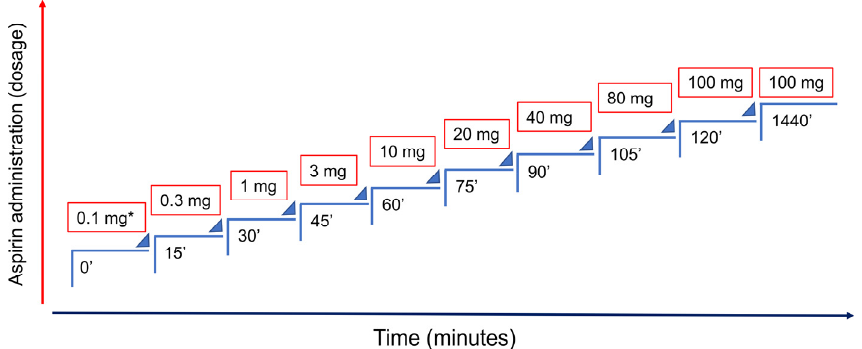
Figure 3. Aspirin desensitization protocol. The asterisk (*) represents the recommended starting dose for pregnant women who had a serious hypersensitivity reaction (anaphylaxis). If not, the protocol can be started at step 3 (1 mg). Adapted from Rossini et al. [40].